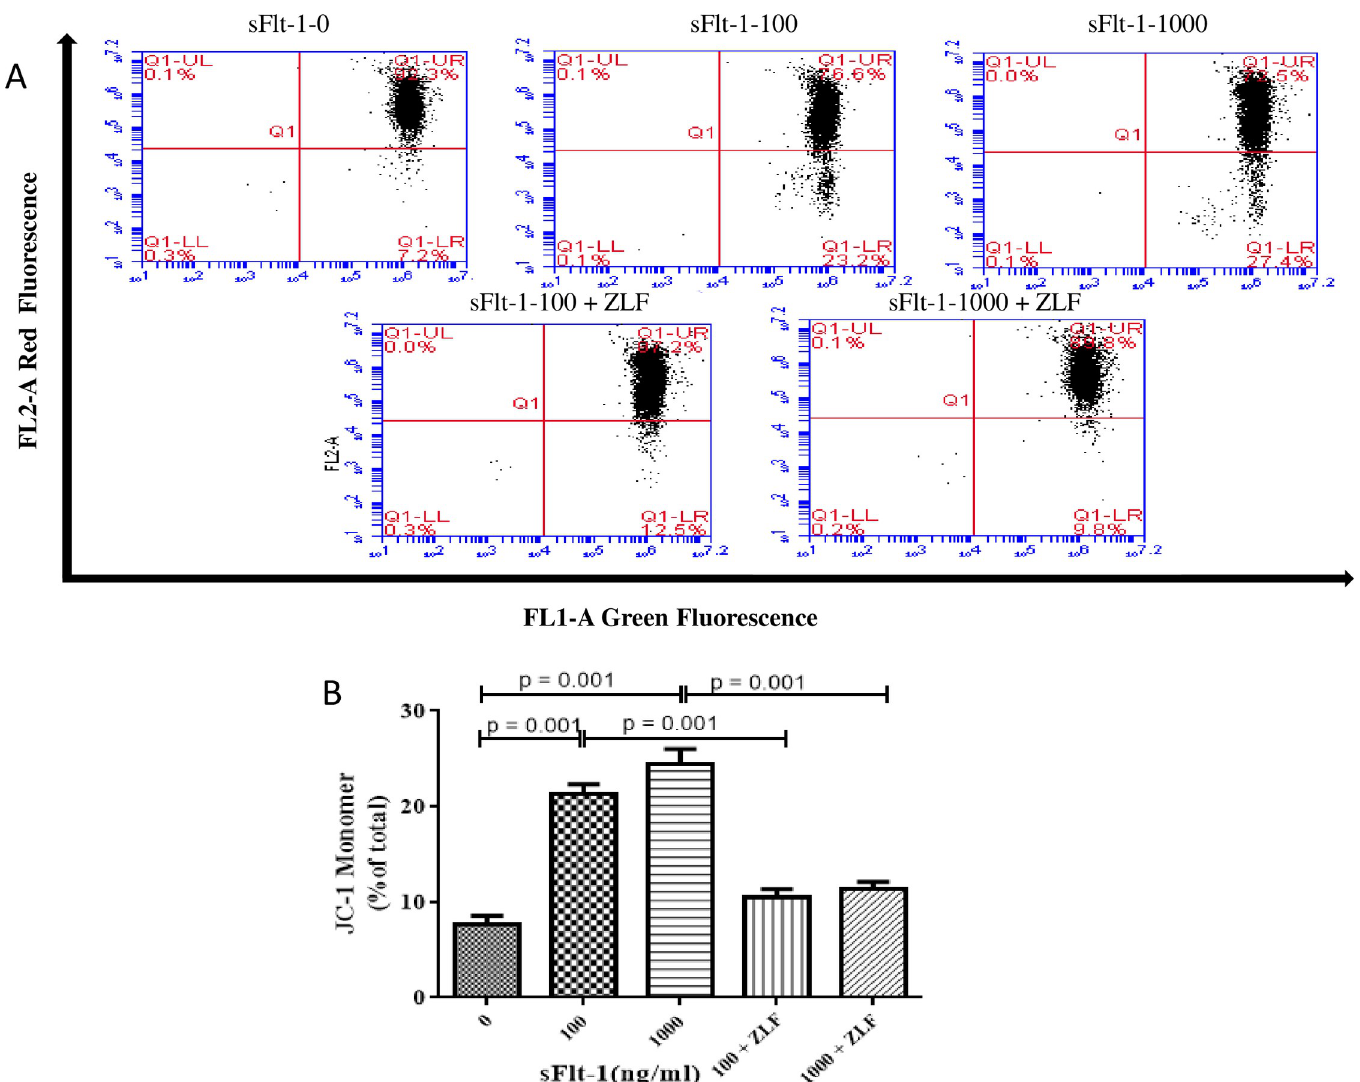
Fig 7. JC-1 monomer increased with the stimulation of sFlt-1 and decreased after administration of Z-LEHD-FMK in HUVECs. A: Effect of Z-LEHD-FMK on sFlt- 1-induced disruption of mitochondrial membrane potential in HUVECs. B: statistical result of the percentage of JC-1 monomer in different groups. HUVECs with low Δ C m increased from 7.63% in untreated cells to 21.33% in cells treated with 100 ng/ml sFlt-1, and further increased to 24.5% in cells with 1000 ng/ml sFlt-1. These effects were alleviated by addition of